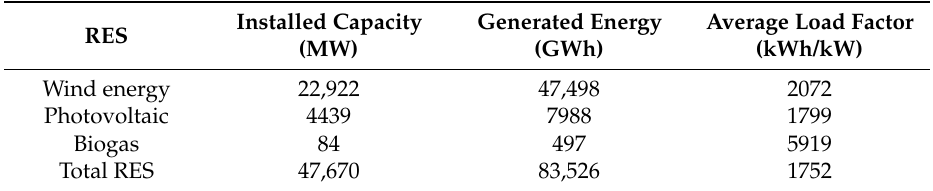
Table 1. Power capacity, generated energy and average load factor for RES generation technologies in Spain in 2017 (data from [11]). Installed Capacity Generated Energy Average Load Factor RES (MW) (GWh) (kWh/kW) Wind energy 22,922 47,498 2072 Photovoltaic 4439 7988 1799